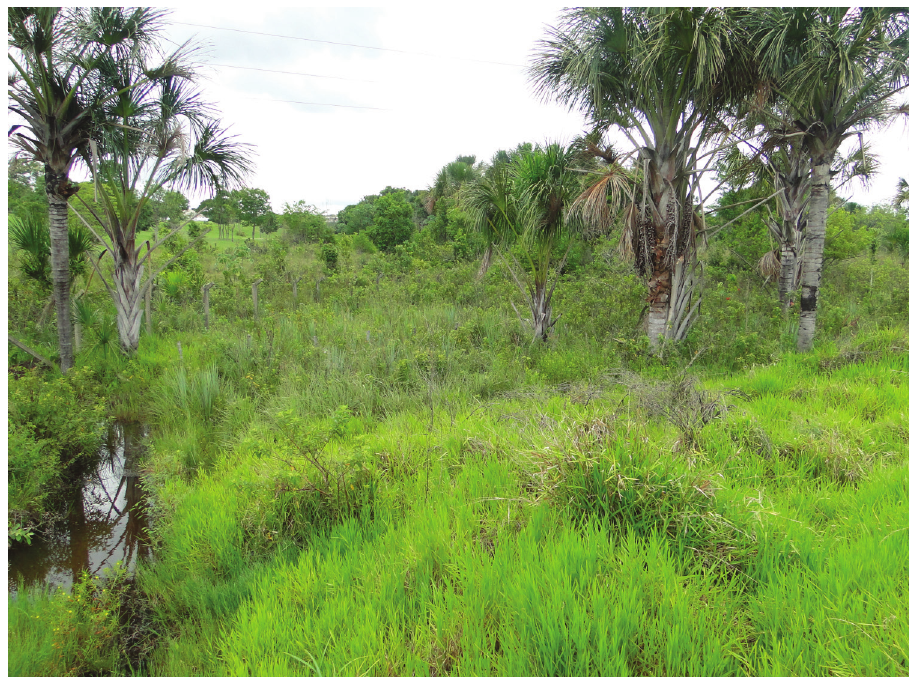
Figure 4. First order stream (typical “veredas” habitat), tributary of headwaters of Rio Pardo, M. interruptus type locality.